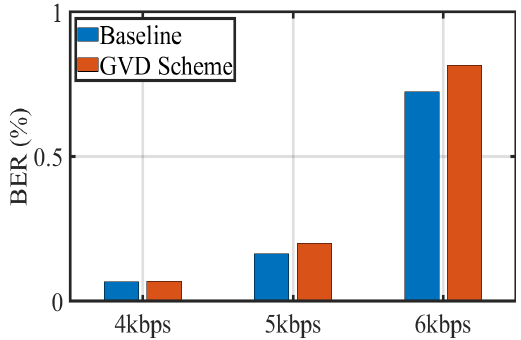
Figure 8. BER with variable transmission